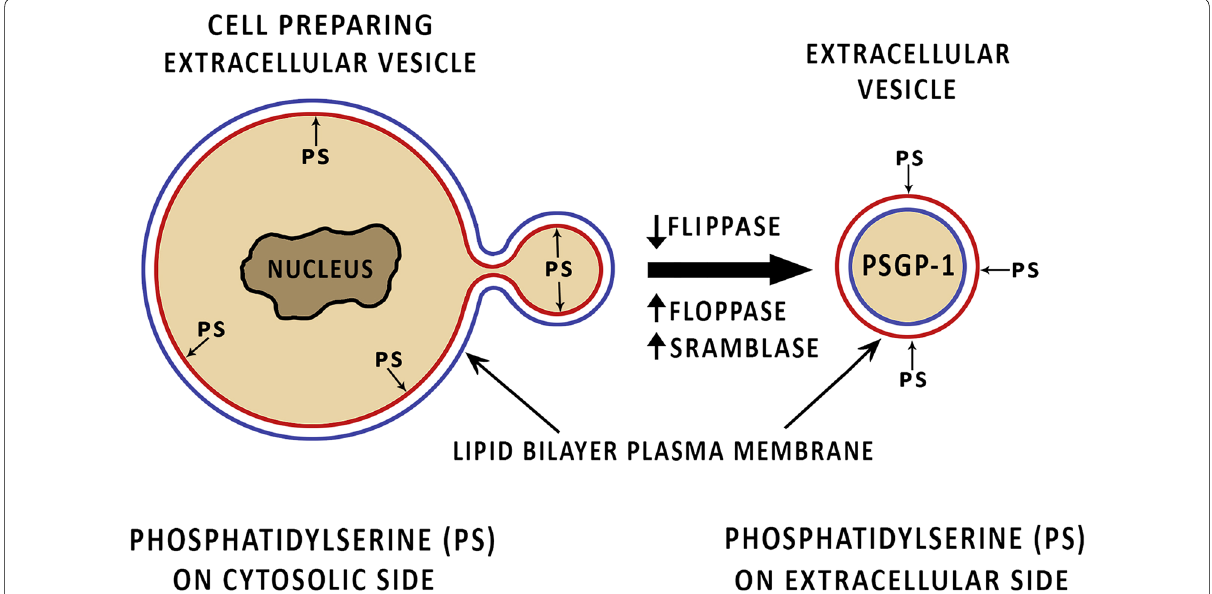
Fig. 1 The normal cell membrane is an asymmetrical bilayered structure with phosphatidylserine- and phosphatidyl-ethanolamine-enriched cytosolic layers, maintained by flippase, floppase and scramblase. As extracellular vesicles are formed, the flippases is inactivated while floppase and scramblase are activated, leading to reversal of the normal asymmetry, creating an outward facing phosphatidylserine enriched layer